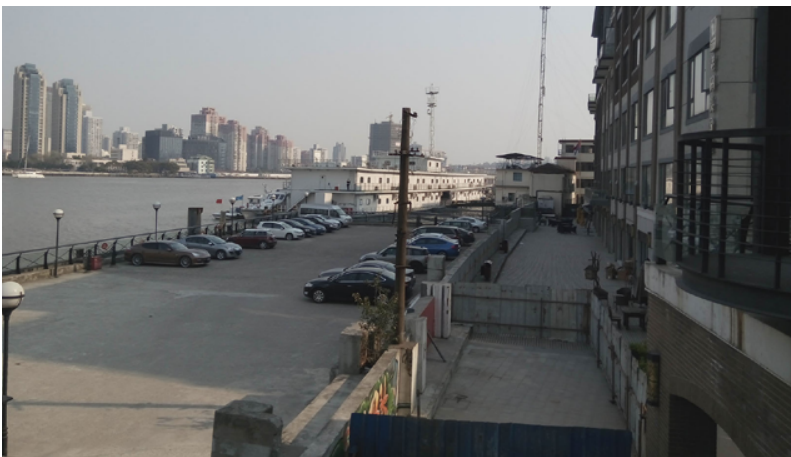
Most creeks disappeared and the few remaining ones, such as Hongkou Creek, are FIG. 5 often disconnected from urban life by floodwalls (photo by author, 2018).